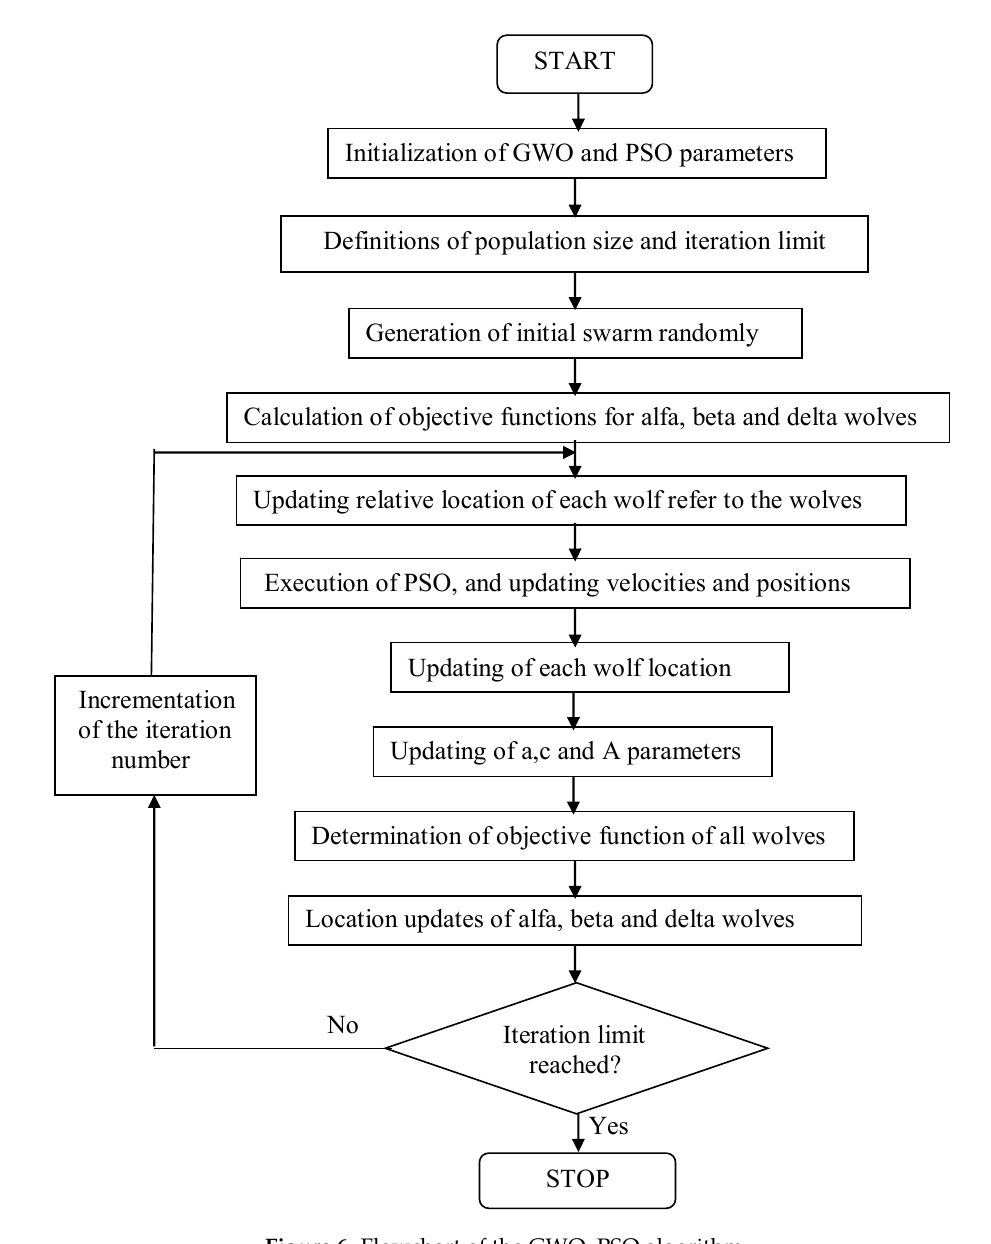
Figure 6. Flowchart of the GWO–PSO algorithm.